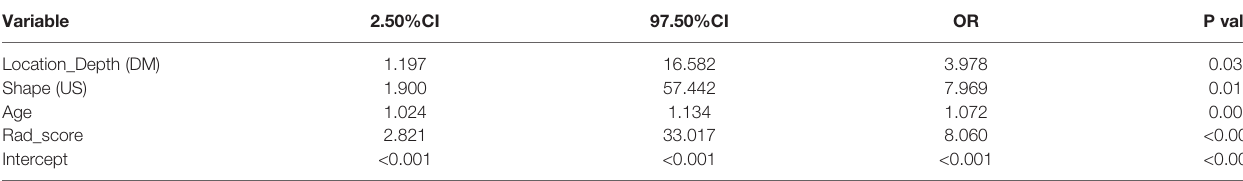
TABLE 4 | Positive results of multivariate logistic regression analysis for the differential diagnosis of round-like breast tumors.